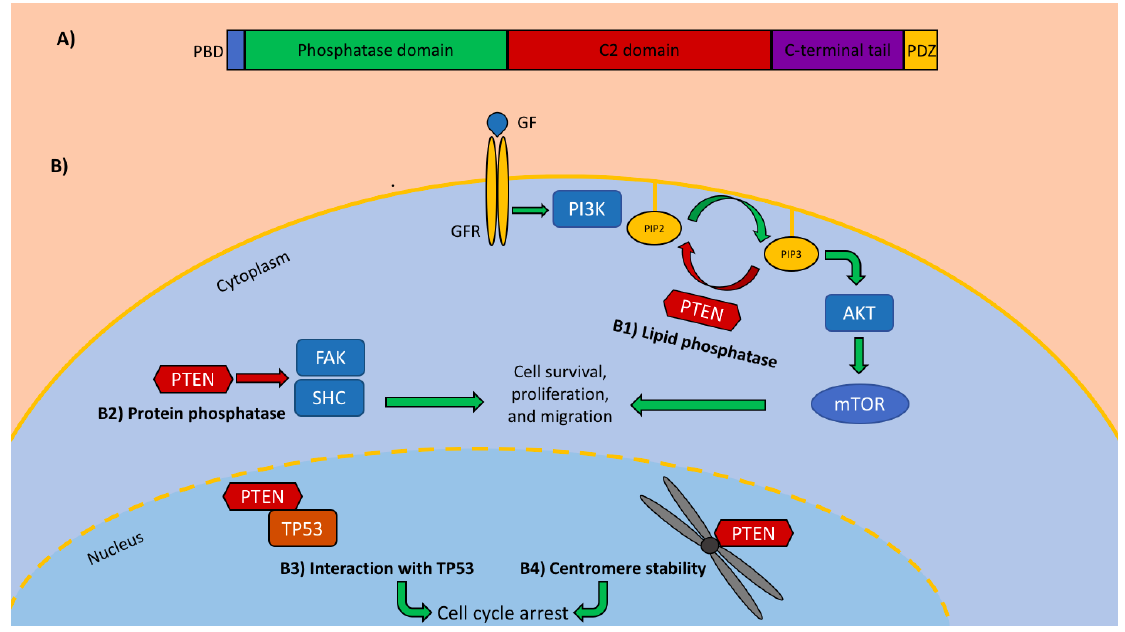
Figure 1. PTEN protein structure and functions. ( A ) PTEN structure. ( B ) PTEN functions. B1) Lipid phosphatase: PTEN dephosphorylates PIP3 to PIP2, inhibiting the PI3K/Akt signaling cascade. B2) Protein phosphatase: PTEN dephosphorylates protein substrates (including FAK and SHC), regulating cell migration and adhesion. B3) Interaction with TP53: via direct interaction with TP53, PTEN enhances TP53 stability and transcriptional activity, resulting in cell cycle arrest. B4) Centromere stability: via direct interaction with the centromere, PTEN preserves the chromosome stability. AKT: protein kinase B; FAK: focal adhesion kinase; GF: growth factor; GFR: growth factor receptor; mTOR: mammalian target of rapamycin; PBD: PIP2 binding domain; PI3K: phosphatidylinositol 3-kinase; PIP2: phosphatidyl-inositol-4,5-diphosphate; PIP3: phosphatidyl-inositol-3,4,5-triphosphate; PTEN: phosphatase and tensin homolog; SHC: Src homology 2 domain-containing protein; TP53: tumor protein p53.